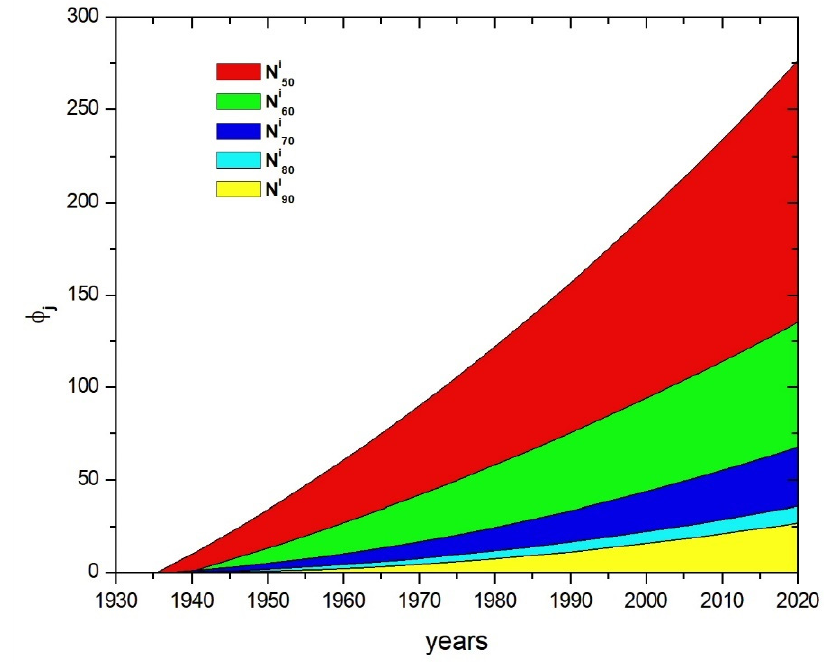
Figure 5. Same as in Figure 3 except using nonlinear best fit. Table 1. For each threshold, ∝ is the coefficient of the second-order term for the non-linear fitting; R squared ( 𝑅 (cid:2870) ) and the standard-deviation ( 𝜎 ) are the statistical parameters from the fitting proce- dure.